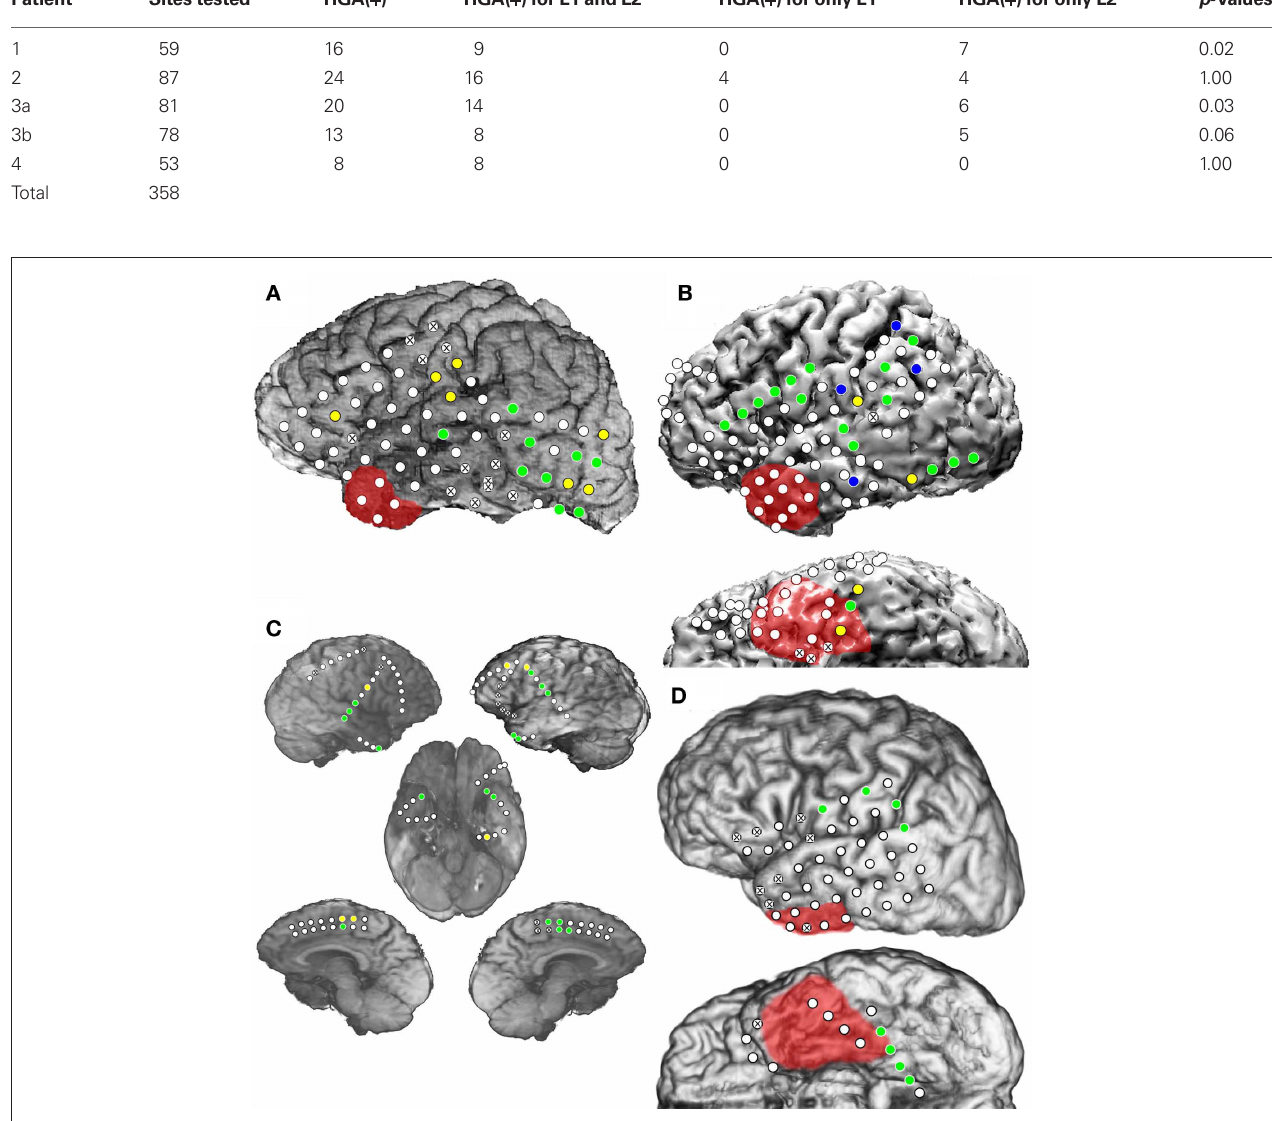
FiGuRE 2 | Electrocorticographic spectral mapping of visual object naming in L1 and L2 in Patient 1 (A), Patient 2 (B), Patient 3a (C), and Patient 4 (D). Lateral, interhemispheric and basal views are shown when applicable. Electrodes used as ground or reference electrodes and those containing electrode artifact are